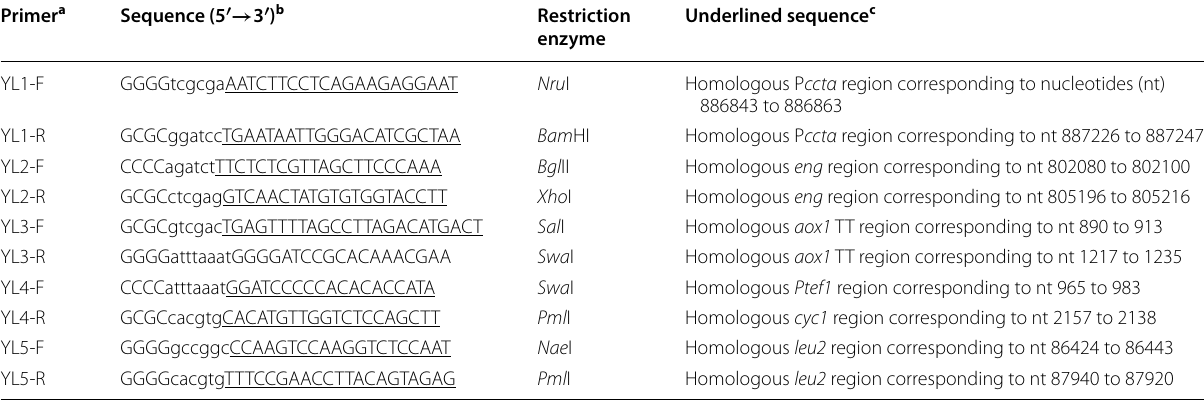
a F forward primer, R reverse primer b Lowercase letters indicates the restriction endonuclease recognized site denoted in the next column c Nucleotide numbering has been taken according to the sequence depicted in the access number mentioned in the section of Materials and methods